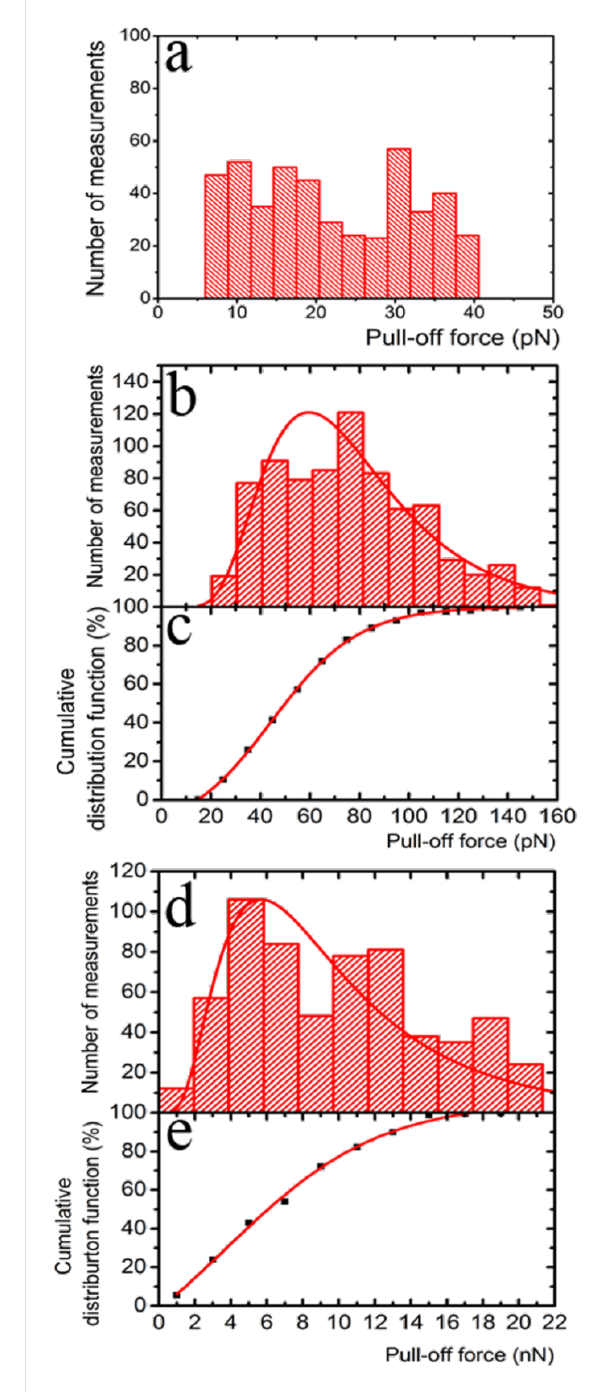
Distribution of the pull-off force between an array of sharp silicon peaks and: (a) a hollow glass sphere; (b) a mercury drop; (c) cumula- tive frequency chart for the latter; (d) distribution of the pull-off force between the multi-scaled rough diamond surface and a mercury drop, and (d) its corresponding cumulative frequency chart. Bin size = 2 σ for all distributions. In the distribution charts (b) and (d) the red line is a log-normal fit (a guide to the eye). In the cumulative frequency charts, the red line corresponds to a Boltzmann sigmoidal fit that is also a guide to the